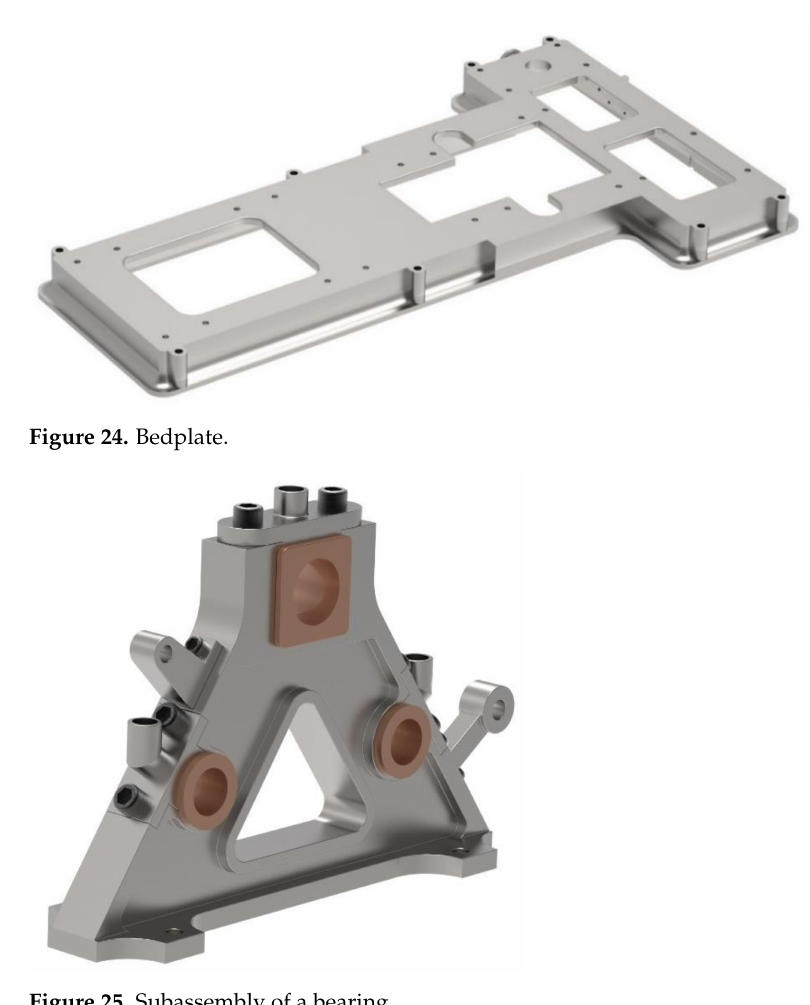
Figure 25. Subassembly of a